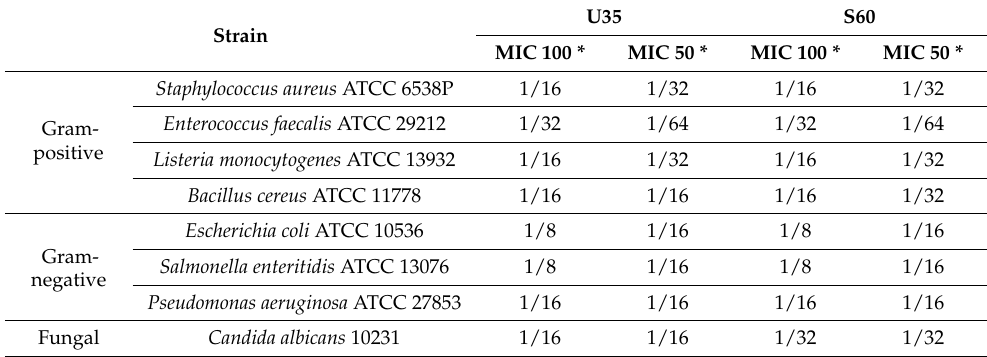
Table 6. Results for the in vitro quantitative study of antimicrobial activity (MIC test). U35 S60 Strain MIC 100 * MIC 50 * MIC 100 * MIC 50 * Staphylococcus aureus ATCC 6538P 1/16 1/32 1/16 1/32 Enterococcus faecalis ATCC 29212 1/32 1/64 1/32 1/64 Gram- positive Listeria monocytogenes ATCC 13932 1/16 1/32 1/16 1/32 Bacillus cereus ATCC 11778 1/16 1/16 1/16 1/32 Escherichia coli ATCC 10536 1/8 1/16 1/8 1/16 Gram- Salmonella enteritidis ATCC 13076 1/8 1/16 1/8 1/16 negative Pseudomonas aeruginosa ATCC 27853 1/16 1/16 1/16 1/16 Fungal Candida albicans 10231 1/16 1/16 1/32